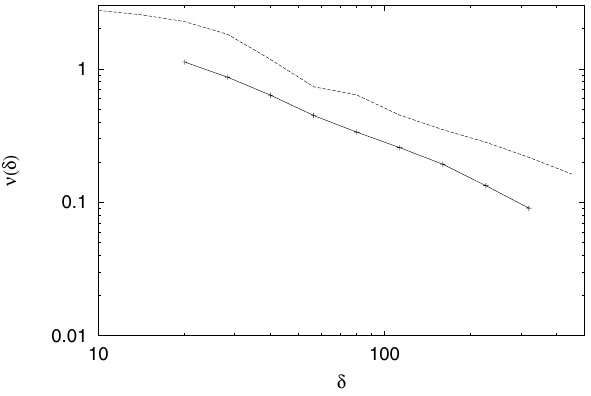
Fig. 4. Finite-Scale Lyapunov Exponent for data (continuous line) and model (dashed line) trajectories. δ is in km and λ(δ) is in day − 1 . The experimental FSLE is computed over all the pairs of trajectories out of 37 drifters; the FSLE from the model is averaged over 10 4 simulations. The simulated λ(δ) has a step-like behavior with one plateau at small scales ( < 50 km) and one at basin scales ( > 100 km), corresponding to doubling times of ∼ 3 days and ∼ 30 days, respectively.